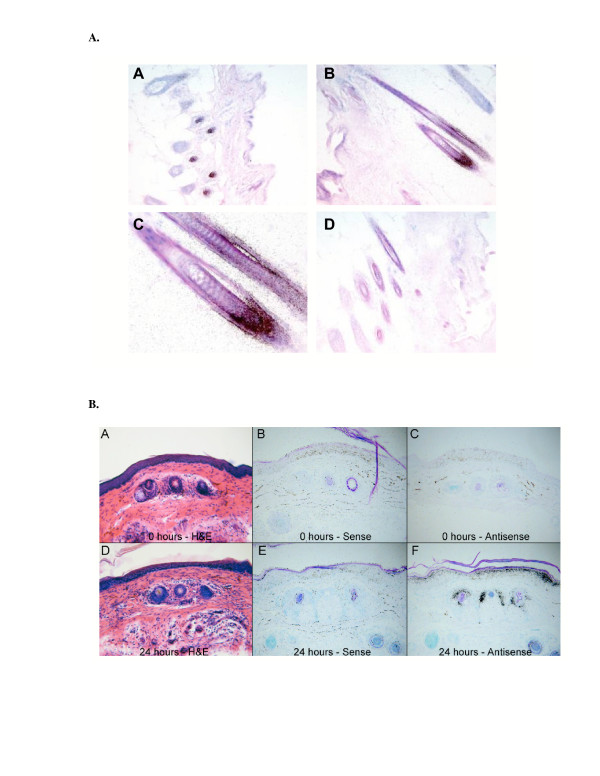
A Localization of mouse S100A7/psoriasin expression to areas of squamous differentiation in skin Sections from formalin fixed paraffin-embedded normal mouse skin samples matched to the frozen tissue from which RNA was previously isolated for RT-PCR analysis were used for in situ hybridization analysis of mouse S100A7/psoriasin expression. A, B, C increasing magnifications (original is 200X) of sections hybridized with mouse S100A7/psoriasin 35S-labeled antisense cRNA, showing strong focal expression of mouse S100A7/psoriasin RNA in a particular subset of cells surrounding the hair shafts, which are associated with squamous differentiation. D, adjacent section hybridized with mouse S100A7/psoriasin 35S-labeled sense cRNA. B Upregulation of mouse S100A7/psoriasin expression in a model of skin inflammation Sections from formalin fixed paraffin-embedded mouse skin tissue at 0 mins and 24 hours after croton application to the tail skin as described in Materials and Methods. A and D, haematoxylin and eosin stained sections, from 0 and 24 hr treated skin, respectively. B and E adjacent sections from 0 and 24 hr croton oil treated skin, respectively, hybridized with mouse S100A7/psoriasin 35S-labeled sense cRNA. C and F, adjacent sections from 0 and 24 hr croton oil treated skin, respectively, hybridized with mouse S100A7/psoriasin 35S-labeled antisense cRNA.